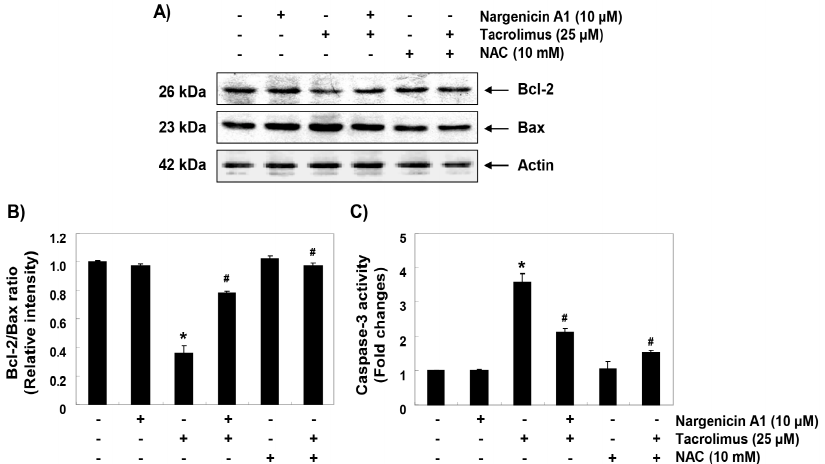
Figure 6. Effect of nargenicin A1 on the expressions of Bcl-2 and Bax and on the activity of caspase-3 in tacrolimus-treated HINAE cells. ( A ) Cells were co-treated with 10 µ M nargenicin A1 or 10 mM NAC with or without 25 µ M tacrolimus for 24 h. Bcl-2 and Bax protein levels were assayed by Western blotting using an enhanced chemiluminescence (ECL) detection system using actin as the internal control. ( B ) Bands were quantified using ImageJ, normalized to actin and ratios were determined. ( C ) Cells lysates were assayed for caspase-3 activity using DEAD-pNA as substrate. Amounts of pNA released were determined by measuring at 405 nm using an ELISA microplate reader. Results are presented as the means ± SD of three independent experiments (* p < 0.05 versus non-treated controls, # p < 0.05 versus tacrolimus-treated cells).